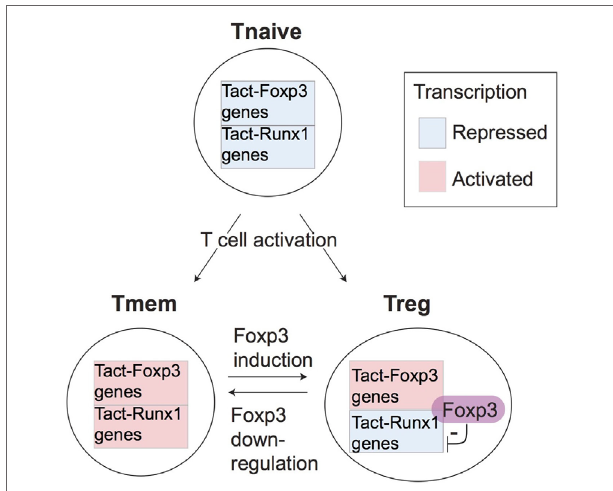
FigUre 5 | A model for the differential regulation of activation genes in Treg and Tmem. The proposed differential regulations of T cell receptor (TCR) signal downstream genes in Treg and Tmem. Since both naturally arising Treg and Tmem are self-reactive T cells, they may frequently receive tonic TCR signals by recognizing their cognate antigens in the periphery. This results in the full activation of both the Tact-Foxp3 and Tact-Runx1 gene modules in Tmem. However, in Treg, Foxp3 represses Tact-Runx1 genes and sustains the expression of Tact-Foxp3 genes, producing the characteristic Treg